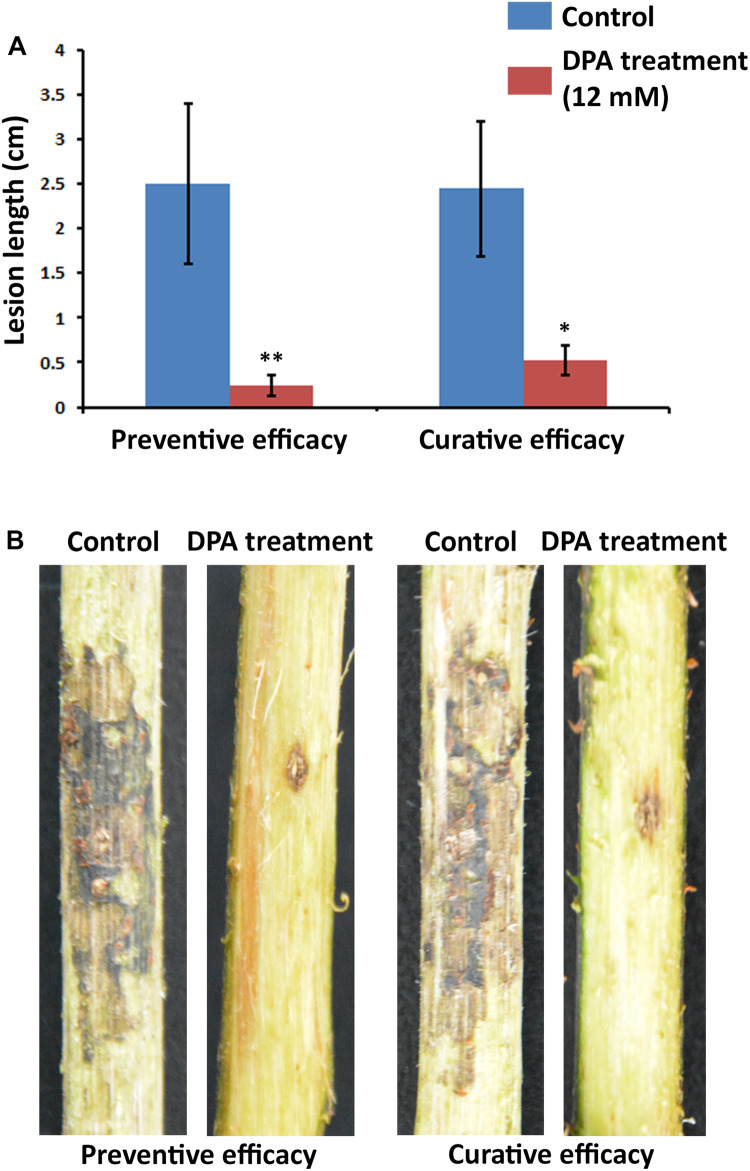
Symptoms of Valsa canker, caused by V. pyri, in wounds of Cuigan pear trees. (A) Canker lesion length after inoculation of V. pyri conidia. DPA treatment was performed by spraying a DPA aqueous solution (12 mM). Water was sprayed in the control experiment. (B) Images of the symptoms of Valsa canker after application of DPA (12 mM). Both curative and preventive efficacies of DPA were examined. The obtained results indicated that DPA can reduce the symptoms of Valsa canker, achieving the highest inhibitory activity in preventive applications. Thirty inoculation sites were studied for each condition. Significance levels at *P < 0.05, and **P < 0.01.